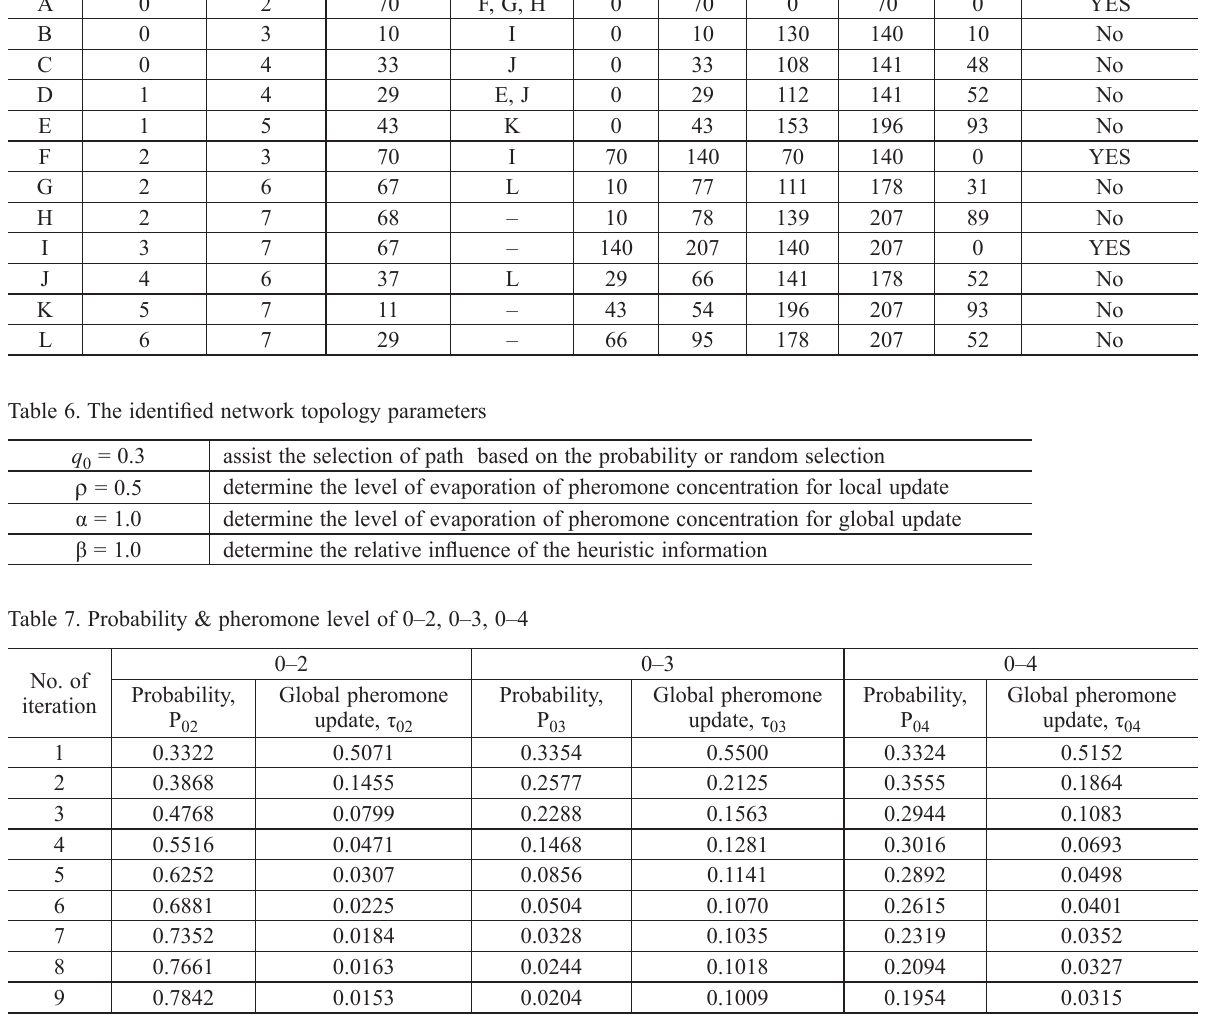
Table 5. Critical path using CPM No